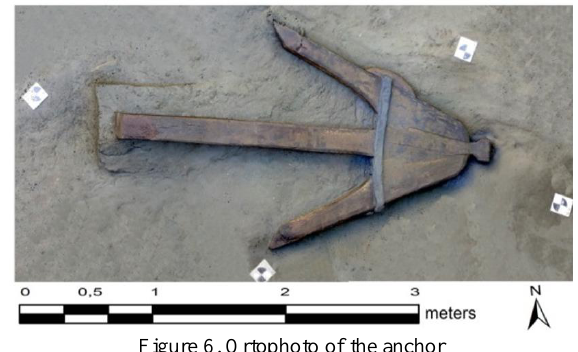
Figure 6. Ortophoto of the anchor